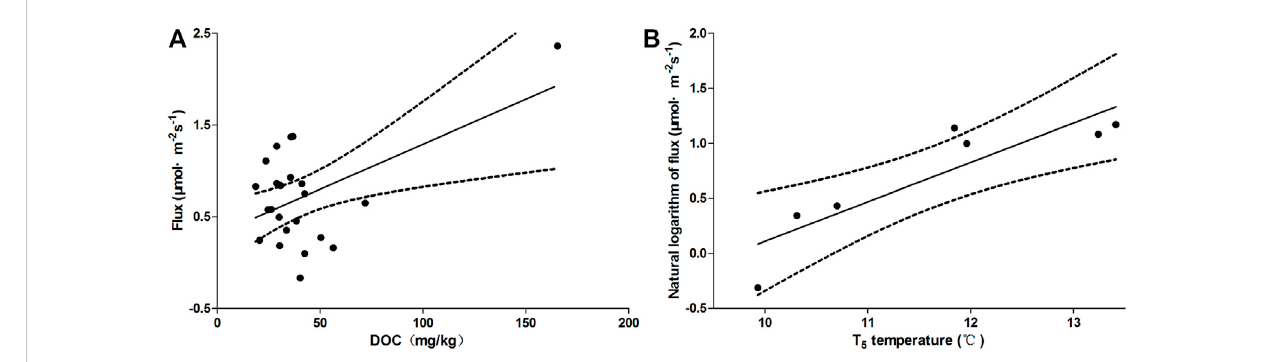
FIGURE 6 The correlation between ecosystem respiration and soil properties. (A) the correlation between ecosystem respiration from mud fl at and DOC; (B) the correlation between natural logarithm of ecosystem respiration from meadow and T5 temperature.